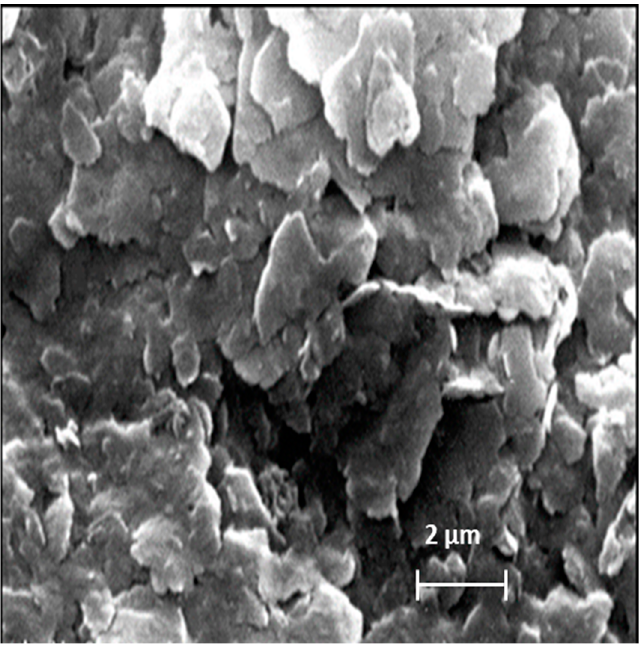
Figure 3. SEM analysis of raw